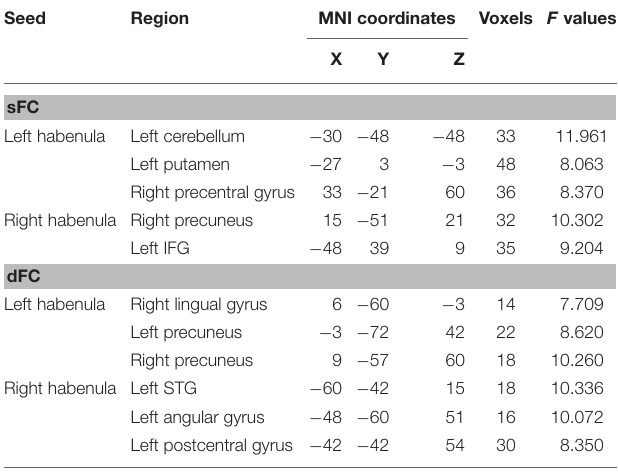
TABLE 2 | Brain regions showing significant FC differences across the three study